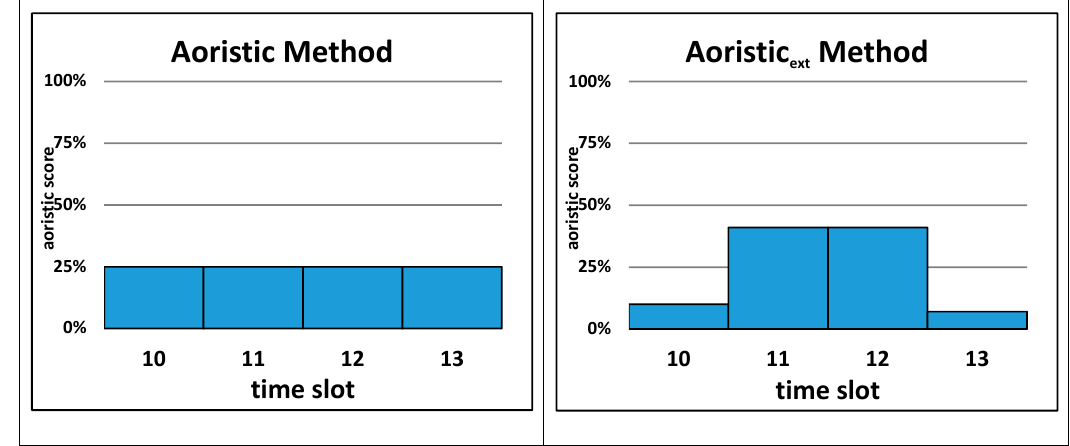
Figure 2 . An example of the results of the aoristic and aoristic ext temporal approximation methods. Figure 2. An example of the results of the aoristic and aoristic